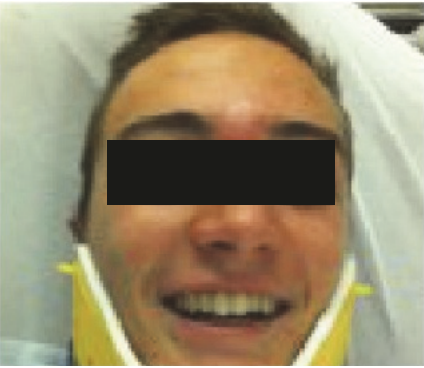
Figure 1: Early postinjury view showing acute glabellar ecchymosis and swelling.